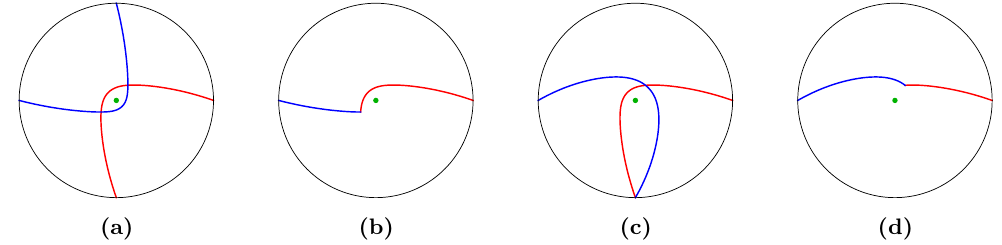
Figure 8. Intersecting annulus brane configurations obtained from taking two different strip branes at α = 2 < 1 and rotating them with respect to each other. By taking particular legs of 3 the individual branes that meet at a single intersection point, we get (b) from (a) and (d) from (c). The Lorentzian version of this picture was also considered by